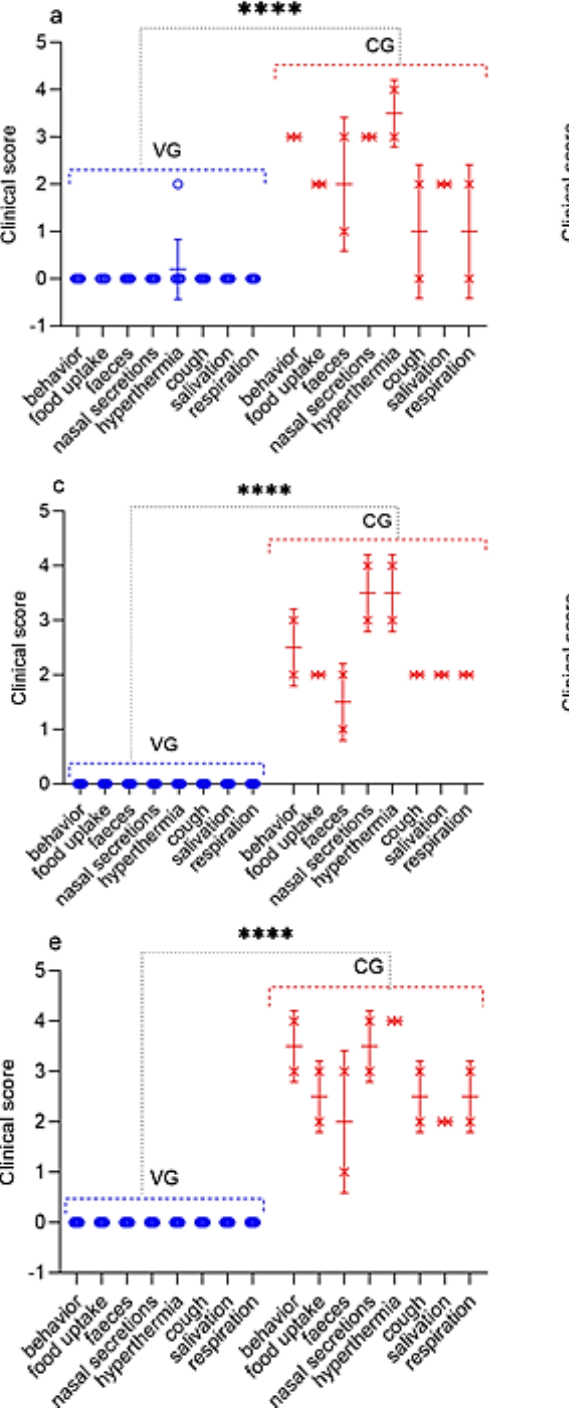
Figure 6. Assessment of the clinical signs in vaccinated and control sheep post challenge with the field strain Kentau-7 of the PPRV. ( a ) Challenge 30 dpv. ( b ) Challenge 90 dpv. ( c ) Challenge 180 dpv. ( d ) Challenge 270 dpv. ( e ) Challenge 360 dpv. VG vaccinated group infected with virulent SPPV ( n = 10). CG control group infected with virulent SPPV ( n = 2). Data are means ± standard errors; **** p < 0.0001.